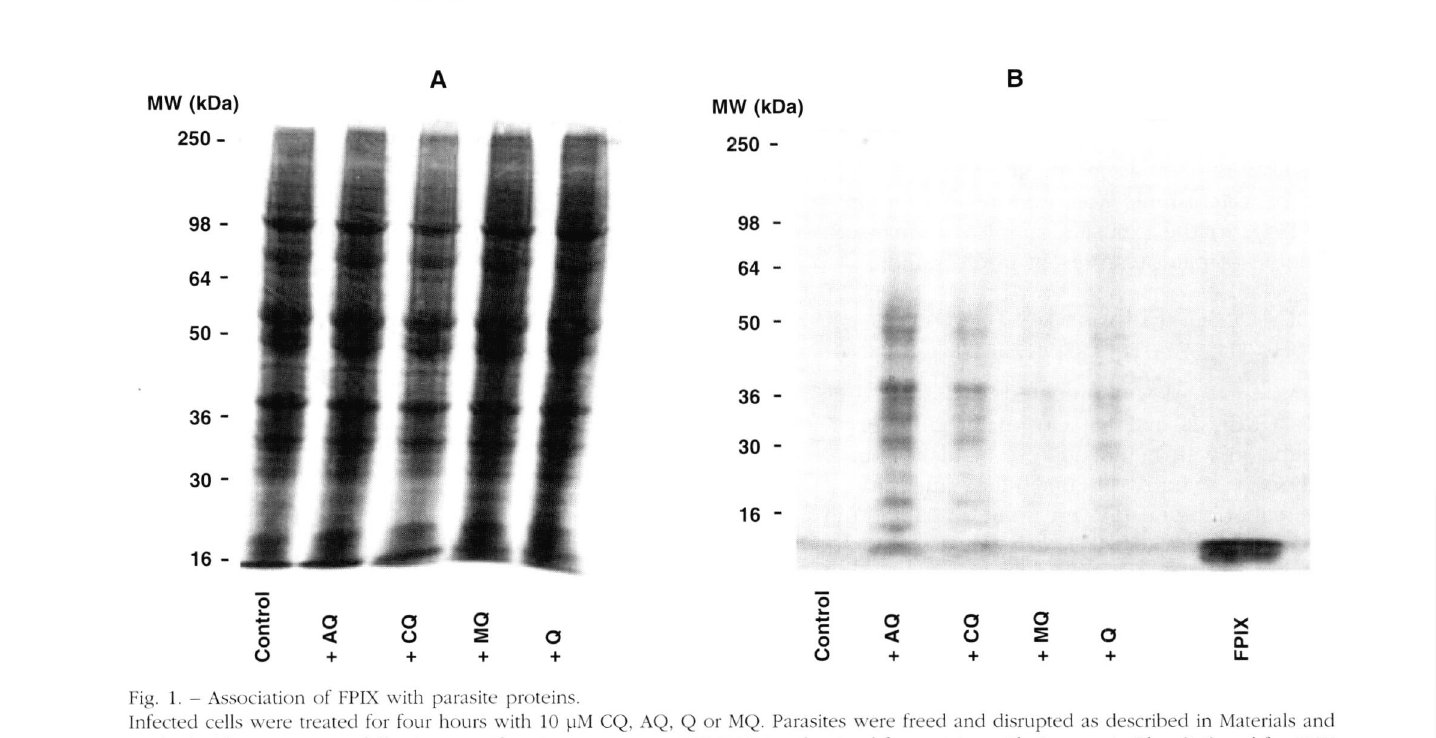
Fig. I. - Association of FPIX with parasite proteins. Infected cells were treated for four hours with 10 uM CQ, AQ, Q or MQ. Parasites were freed and disrupted as described in Materials and Methods. The supernatant following centrifugation was run on SDS-PAGE and stained for proteins with Coomassie Blue (1A) and for FPIX